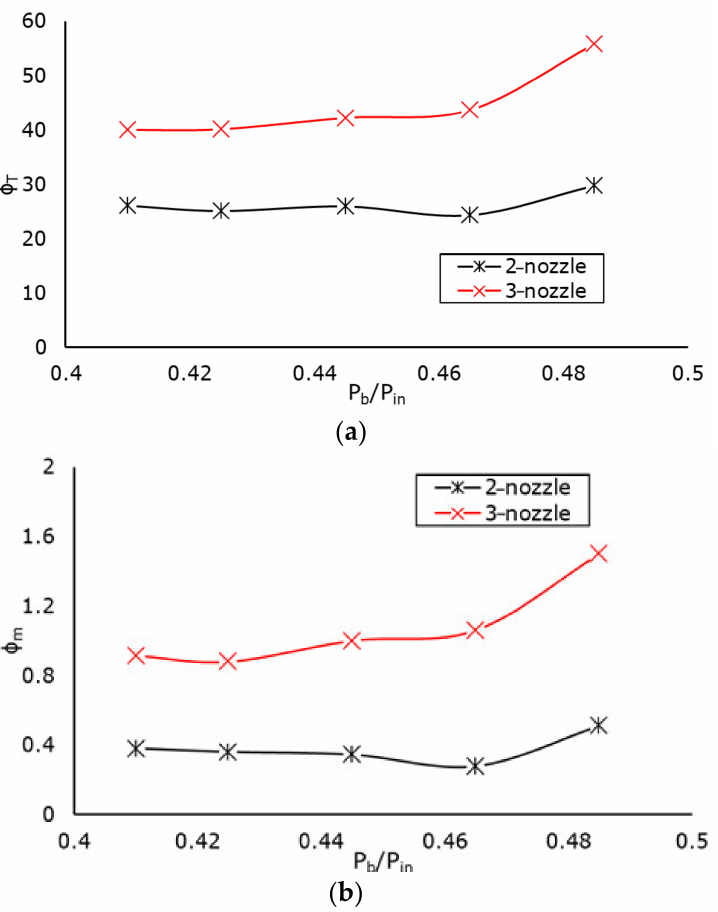
Figure 13. ( a ) Relative enhancement in thermal performance coefficient ( b ) Relative enhancement in mechanical performance